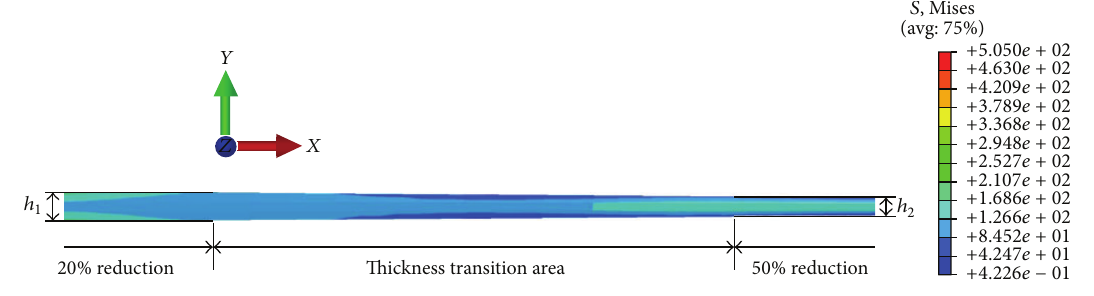
Figure 4: Simulation result with hexahedral mesh size 500 𝜇 m.